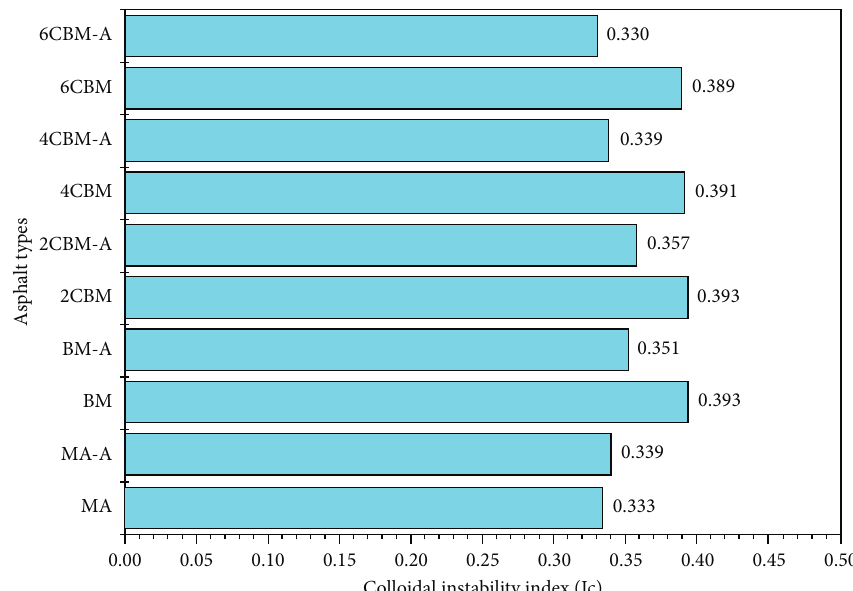
Figure 8: Effect of organic nano-CaCO 3 on colloidal instability index of bioasphalt before and after aging.